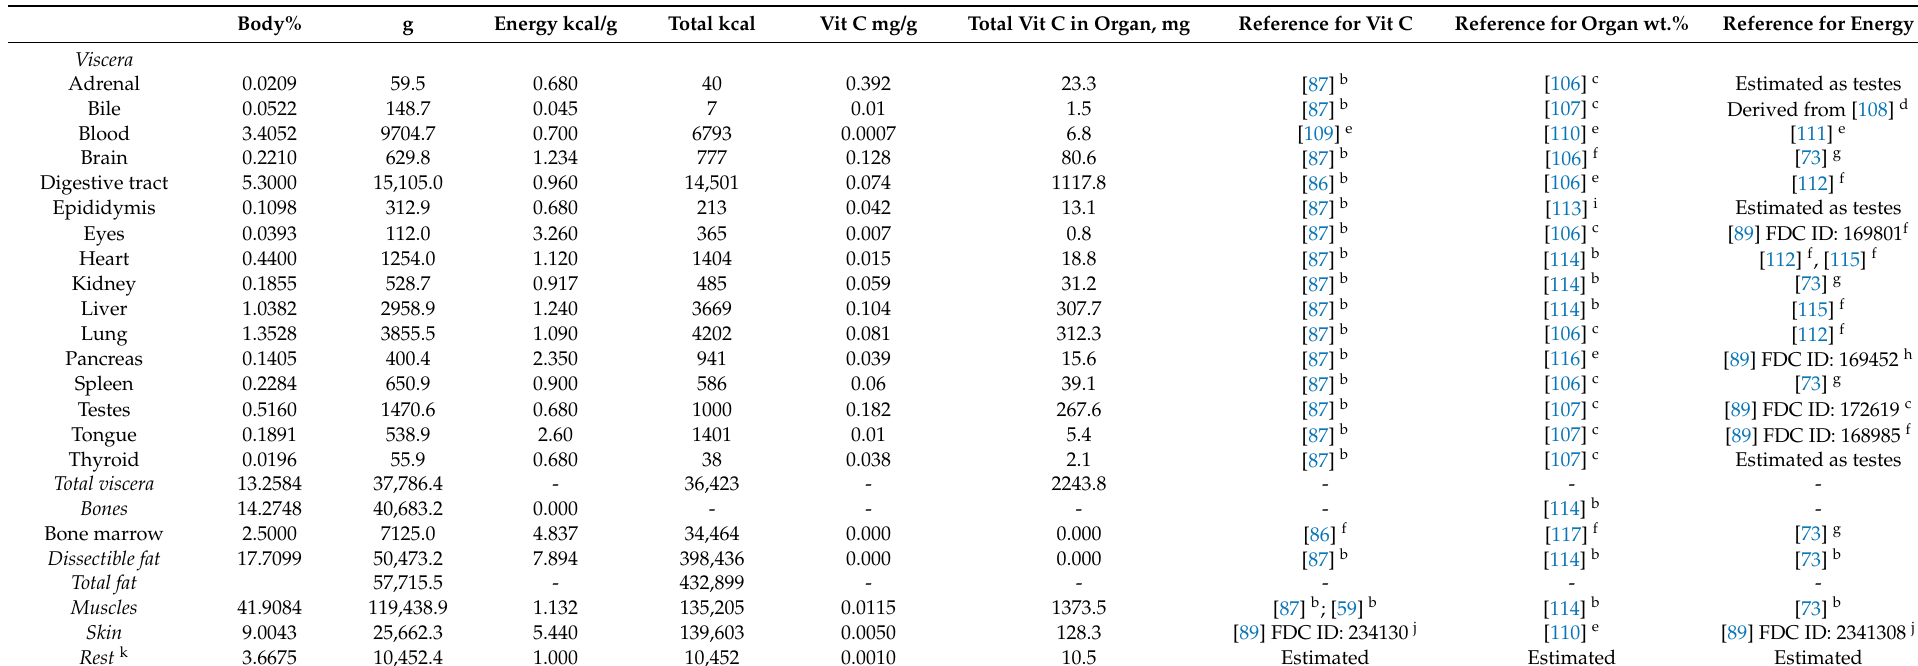
Table 3. Organ weights, energy, and ascorbic acid contents of a medium-sized muskox (285 kg) a